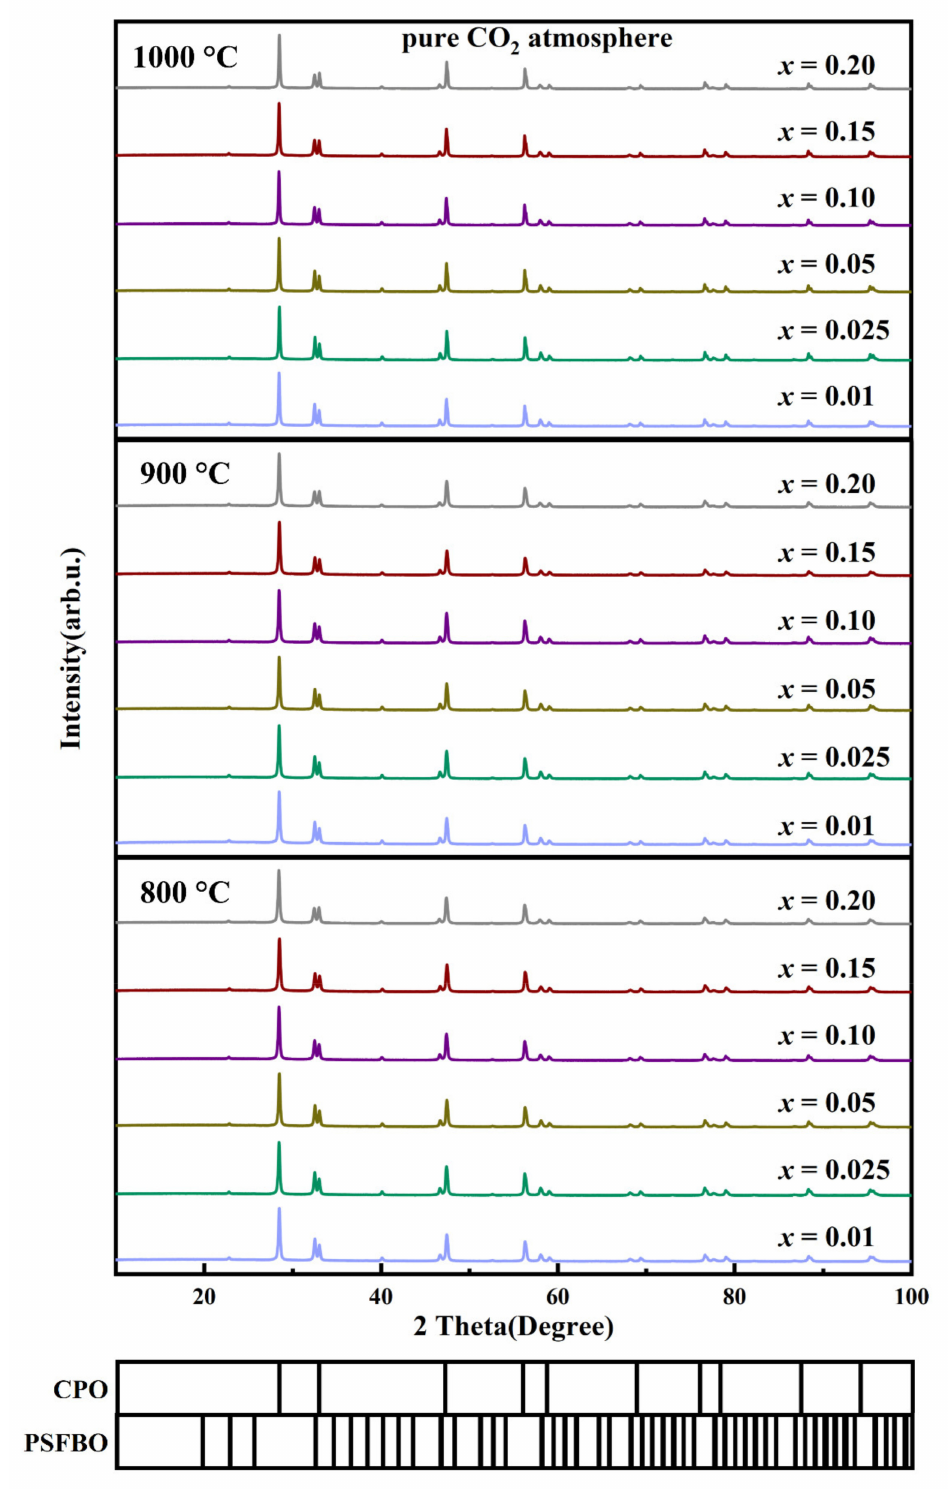
Figure 8. XRD patterns of the obtained 60CPO-40PSF 1 − x B x O powders after being calcined under pure CO 2 gas at 800, 900, and 1000 ◦ C for 24